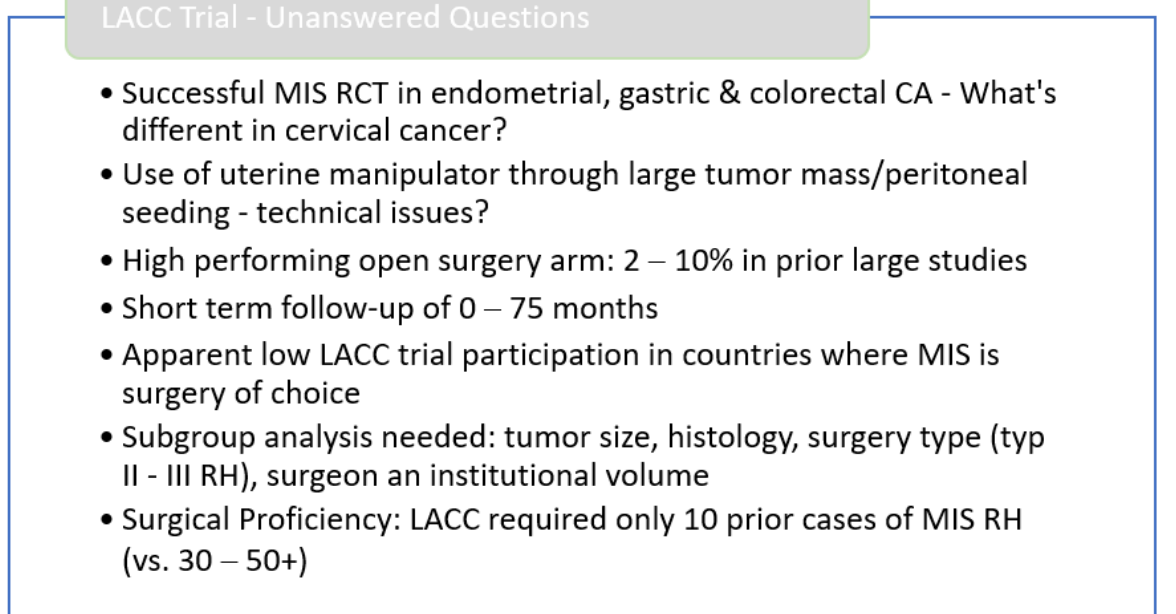
Figure 1. Summary of initial criticism at ASCO 2018 presented by Ginger J. Gardner, MD.